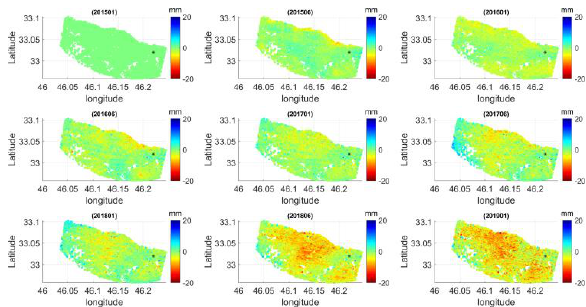
Figure 8. Displacement time-series for Azar area obtained from the PS analysis of the descending